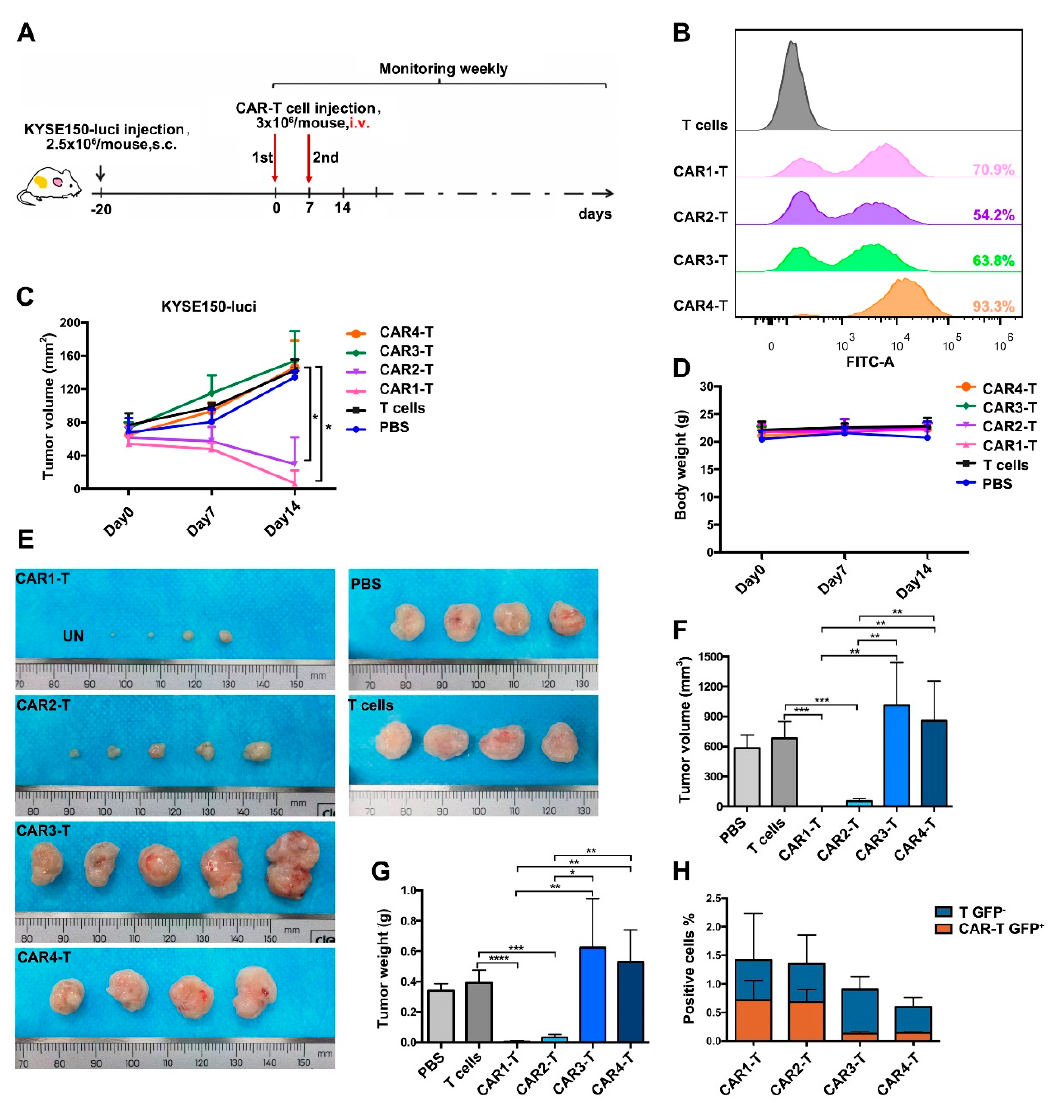
Figure 6. Antitumor effects of anti-EGFR CAR-T cells in vivo. ( A ) Experimental design of the in vivo functional test for CAR-T cells. ( B ) Expression of the anti-EGFR CAR in T cells used for the in vivo experiment was analyzed by FACS. ( C ) Tumor volume changes after intravenous injection of anti- EGFR CAR-T cells into CDX mice with KYSE150-luci cell xenografts. ( D ) Mouse body weight after anti-EGFR CAR-T cell administration. ( E – G ) Tumor sizes ( E , F ) and weights ( G ) at the end of the experiment. ( H ) The proportion of hCD3+ cells and CAR-T cells in the peripheral blood of mice was analyzed before the mice were sacrificed. Unpaired multiple two-tailed t -test, * p < 0.05, ** p < 0.01, *** p < 0.001, and **** p < 0.0001. CDX, cell-line-derived xenograft; i.v., intravenous injection.